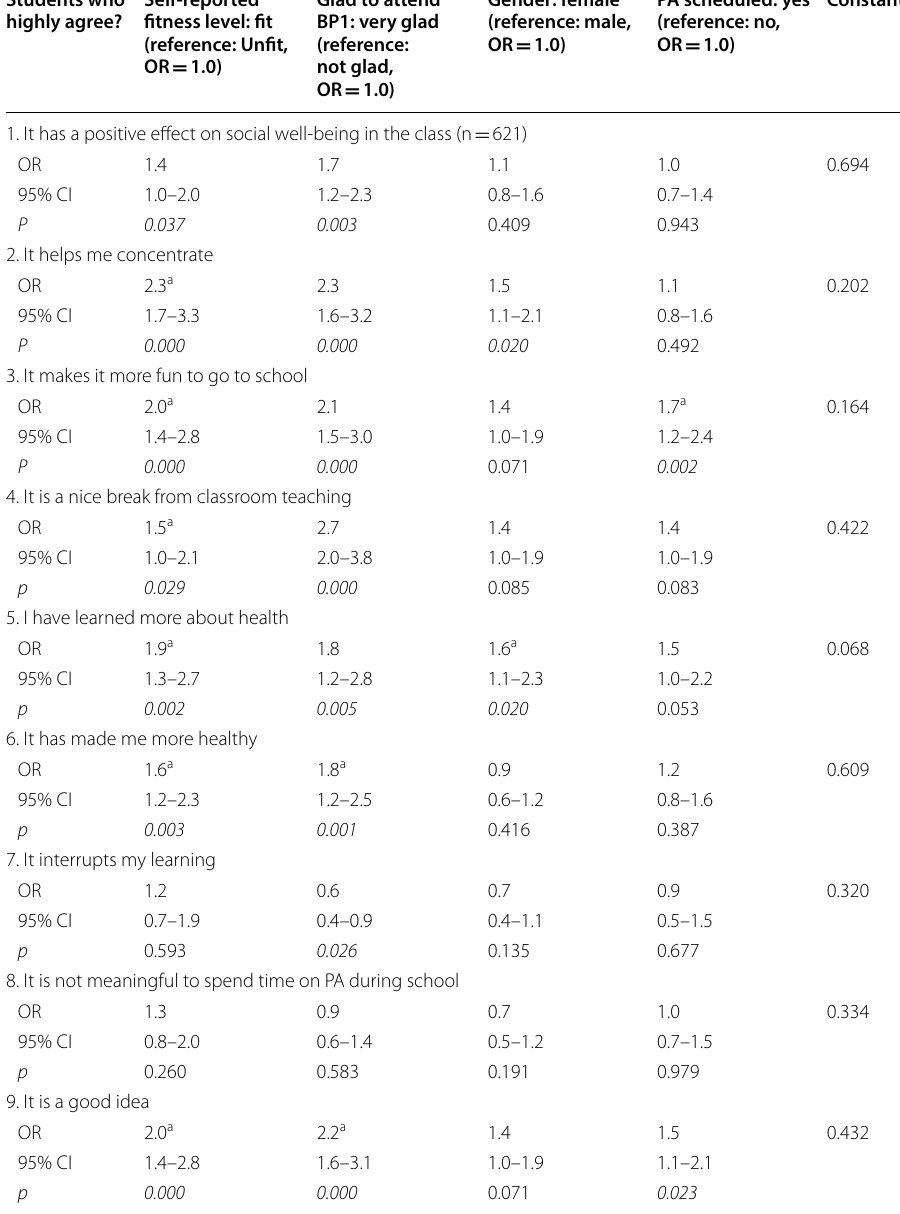
Table 2 Multivariate association between students’ attitude to PA in school and self- reported fitness level, contentment with BP1, gender and scheduled